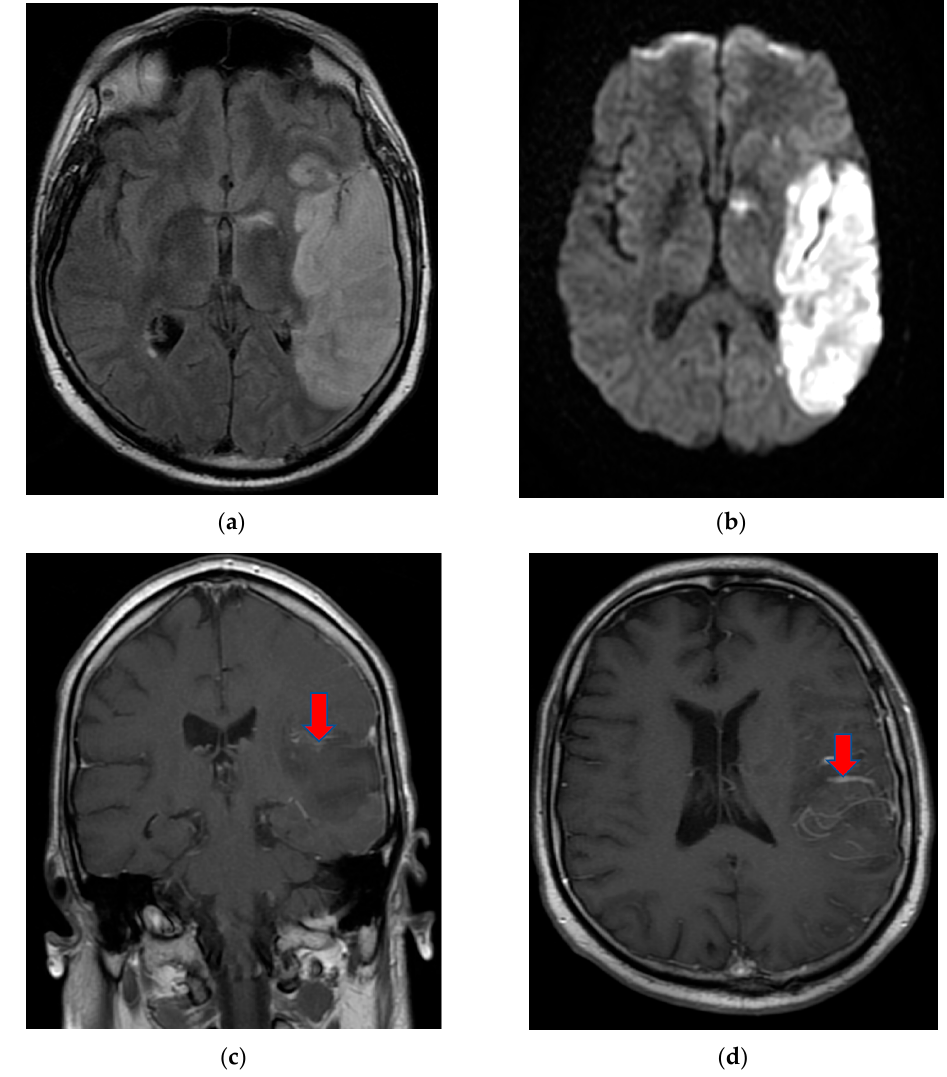
Figure 3. MRI T2 axial Flair ( a ) and axial DWI ( b ) images demonstrated extension of the lesion in the fronto-parieto-temporal left lobes. Coronal T1 FSE ( c ) and axial T1 FSE ( d ) with contrast showing a hyperdense aspect of the left middle cerebral artery wall, suggestive of infectious/autoimmune vasculitis.